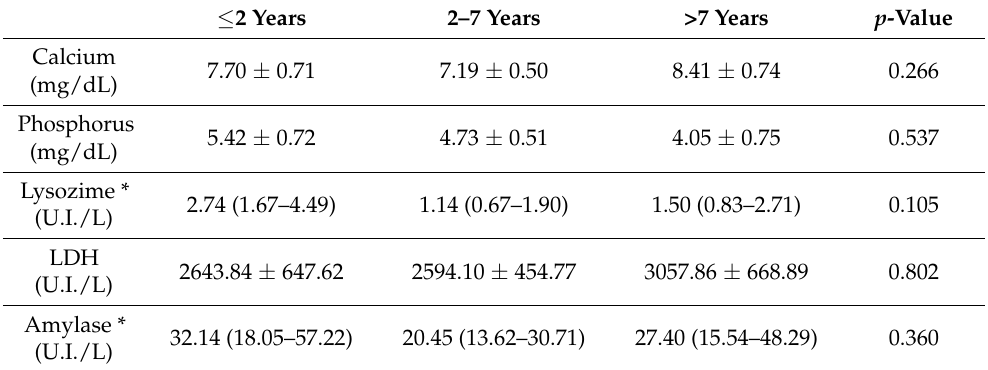
Table 5. Salivary biochemistry (mean ± standard error) in dogs of different classes of age ( ≤ 2 years; 2–7 years; >7 years).